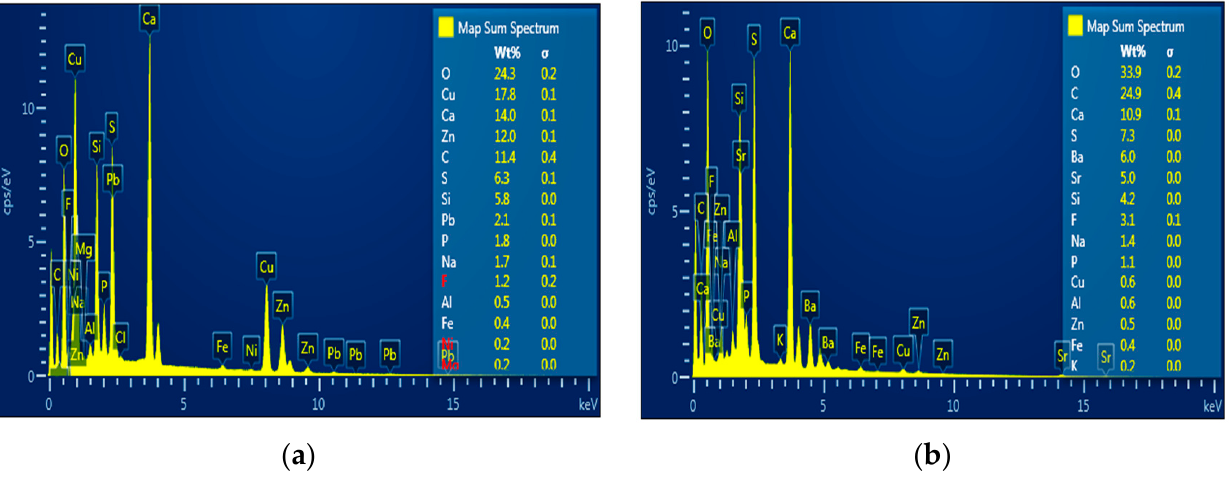
Figure 7. EDS analysis of phosphate waste after ( a ) 30 min of treatment and ( b ) 40 min of treatment.